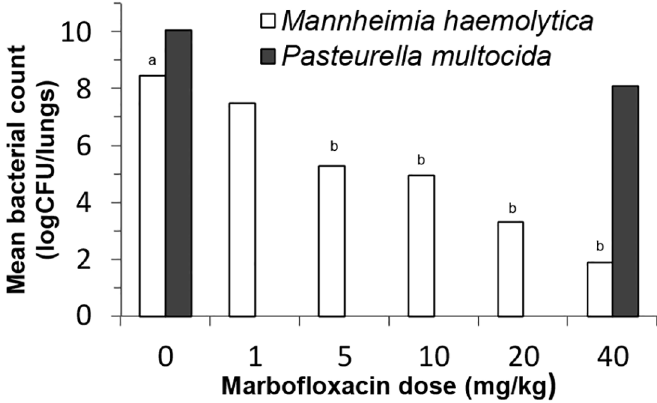
Fig 3. Mean bacterial counts in the lungs of mice infected with P . multocida (dark bars) or with M . haemolytica (white bars) after intraperitoneal administrations of different doses of marbofloxacin. Different letters in superscript above bars indicate that values are statistically